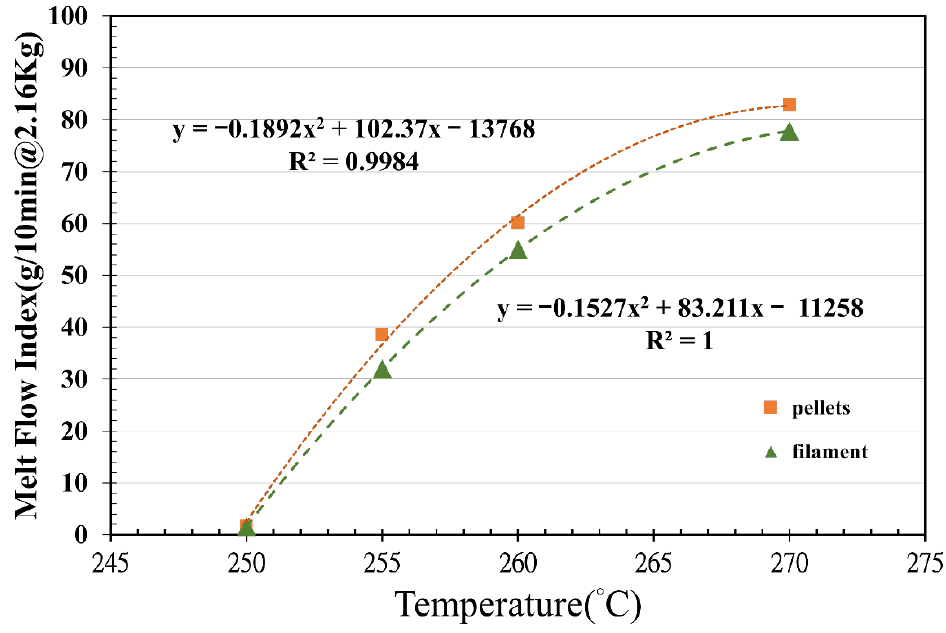
Figure 3. Melt flow index of Tairilin PET 4112XX pellets and filament with respect to heating tem- perature.